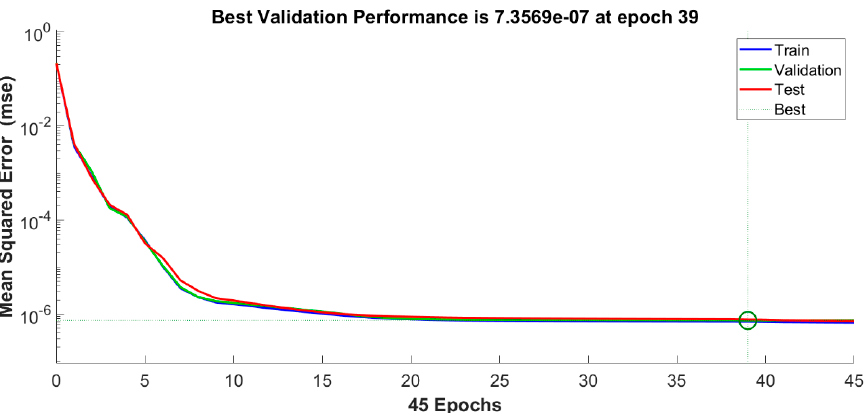
Figure 12. The structure of the utilized ANN and the applied settings. ( a ) the structure of the ANN with a hidden layer and input and output layer. ( b ) the training parameters and convergence crite- ria.